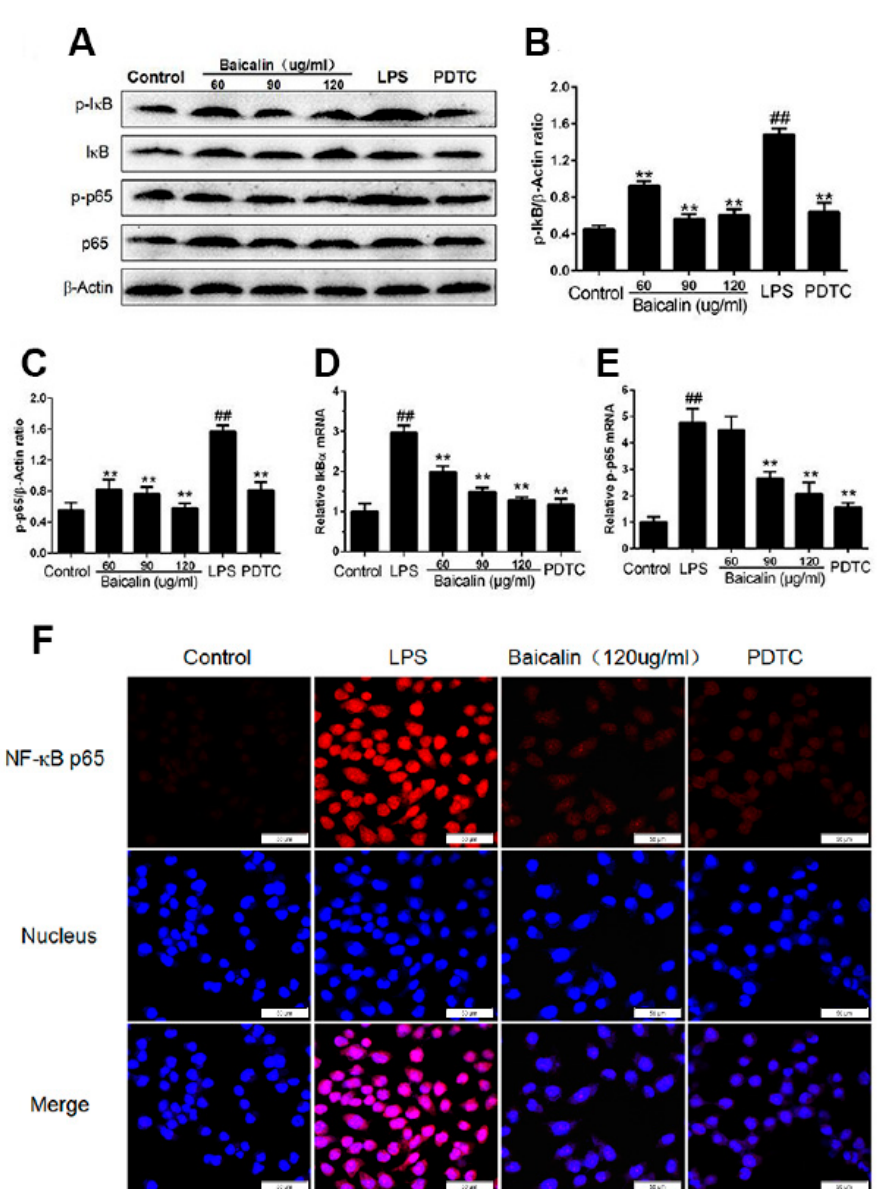
Figure 2. Effect of baicalin on protein expression NF- κ B pathway and NF- κ B p65 transcriptional activity of RAW 264.7 cells. Cells were treated with LPS (4 µ g/mL), baicalin (60, 90, and 120 µ g/mL), and PDTC (10 µ M): ( A – C ) Protein expression of p-I κ B α , I κ B α , β -actin, NF- κ B p65, and p-p65; ( D ) Rela- tive mRNA expression levels of p- I κ B α normalized to β -actin; ( E ) relative mRNA expression levels of p-p65 normalized to β -actin; ( F ) P65 cellular localization was analyzed by immunofluorescence assay under a laser confocal microscopy, respectively ( × 400). ## p < 0.01 vs. control; ** p < 0.01 vs.